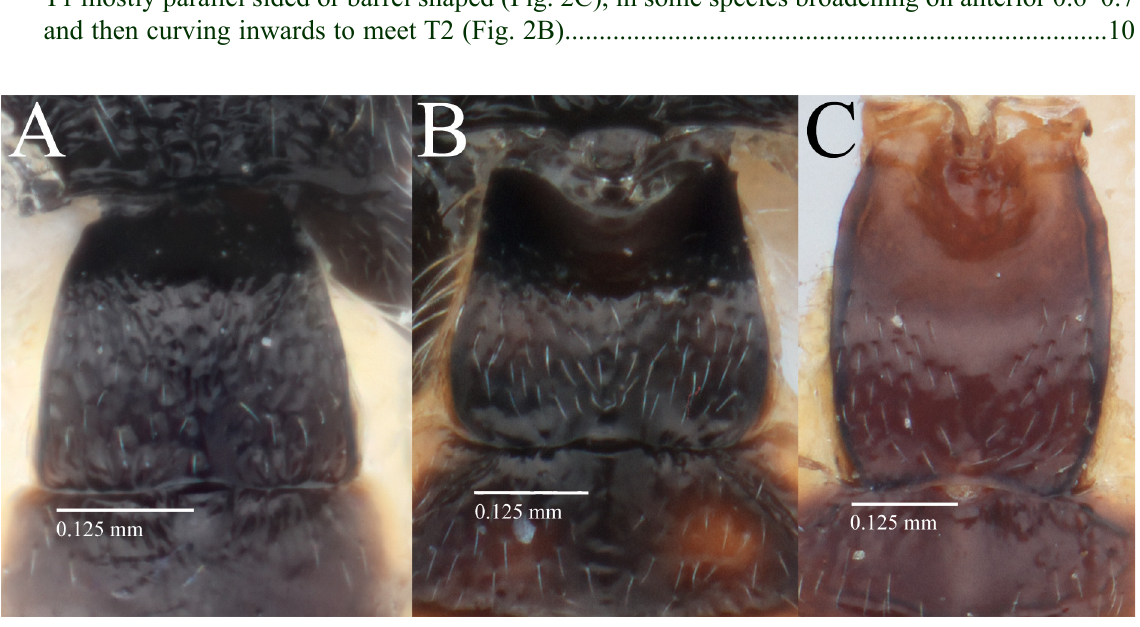
Fig. 2. A . Cotesia ocellata sp. nov., T1 (SAMA 32-44404). B . Cotesia reidarum sp. nov., T1 (QM T246703). C . Cotesia deliadis (Bingham, 1906), T1 (paralectotype,